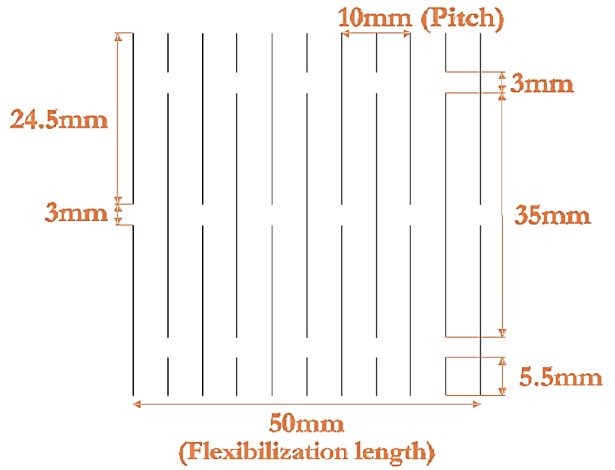
Figure 4. Kerfing pattern and dimensions for a flexibilization length of 50 mm and a kerfing pitch of 10 mm.